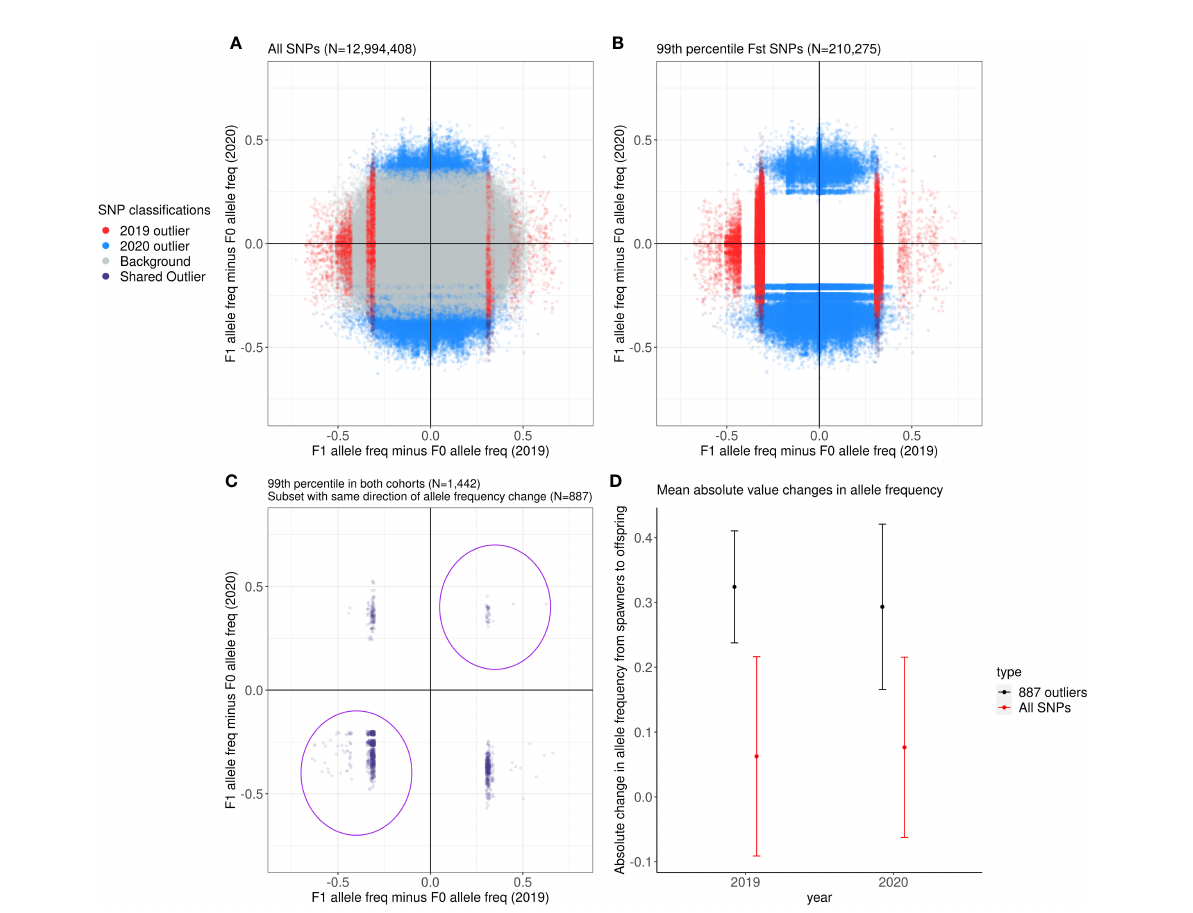
FIGURE 5 The allele frequency difference between the F1 and F0 in 2019 compared to that in 2020. Gray dots are SNPs that fell outside the 99th percentile of F ST values of all SNPs, red dots are SNPs that fell in the 99th percentile in the 2019 cohort alone, blue dots are SNPs that fell in the 99th percentile in the 2020 cohort alone, and purple dots are SNPs that fell in the 99th percentile in both cohorts. (A) Displays all SNPs in the dataset, (B) displays the 99th percentile SNPs in the dataset, and (C) displays the 99th percentile SNPs that were shared between the 2019 and 2020 cohorts. The purple dots circled in the fi rst and third quadrants in (C) are the 887 outlier SNPs used in the rest of the analyses. (D) Comparison of the mean absolute change in allele frequency for all SNPs (red) and for the 887 outliers (black) between the spawners and the surviving offspring in each year. The dots represent the mean, with the vertical bars representing ± 2